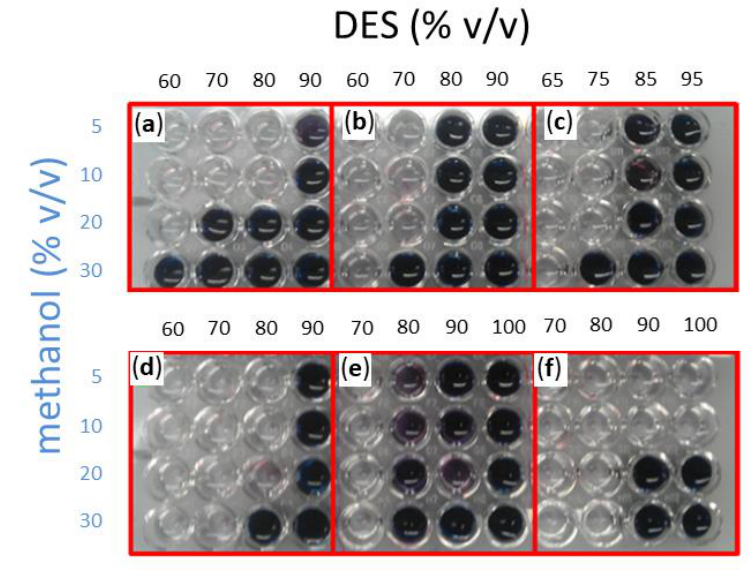
Figure 3. Retained Amy A activity as evaluated after 12 h of reaction in DES:water:MeOH systems at 75 °C. A reaction aliquot was taken to see retaining activity. The assay shown here was carried out with 1% starch ( w/v ) as a substrate at 50 °C. Six different DESs were screened: ( a ) choline